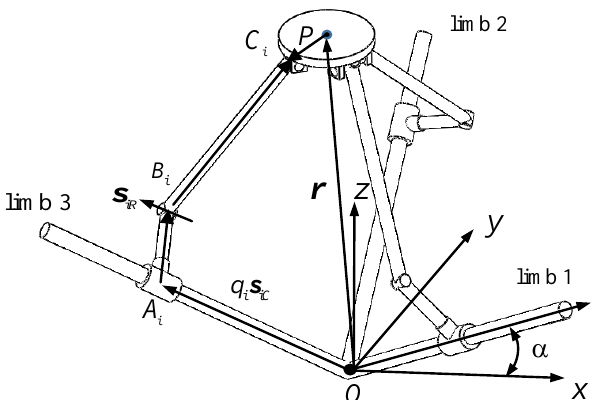
Figure 5. Schematic model of the mechanism.